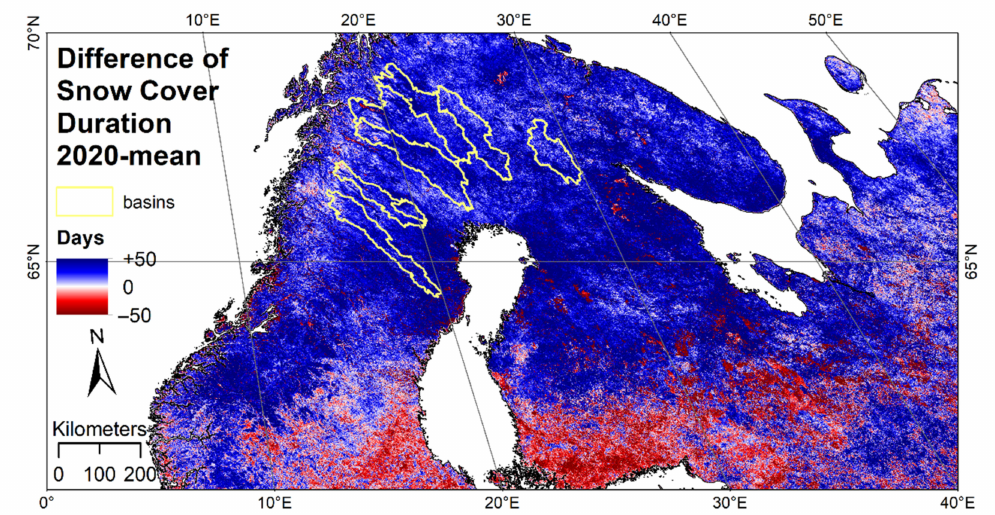
Figure 5. Deviation of snow cover duration for the hydrological year 2020 compared to the mean SCD calculated from the hydrologic year 2001 to